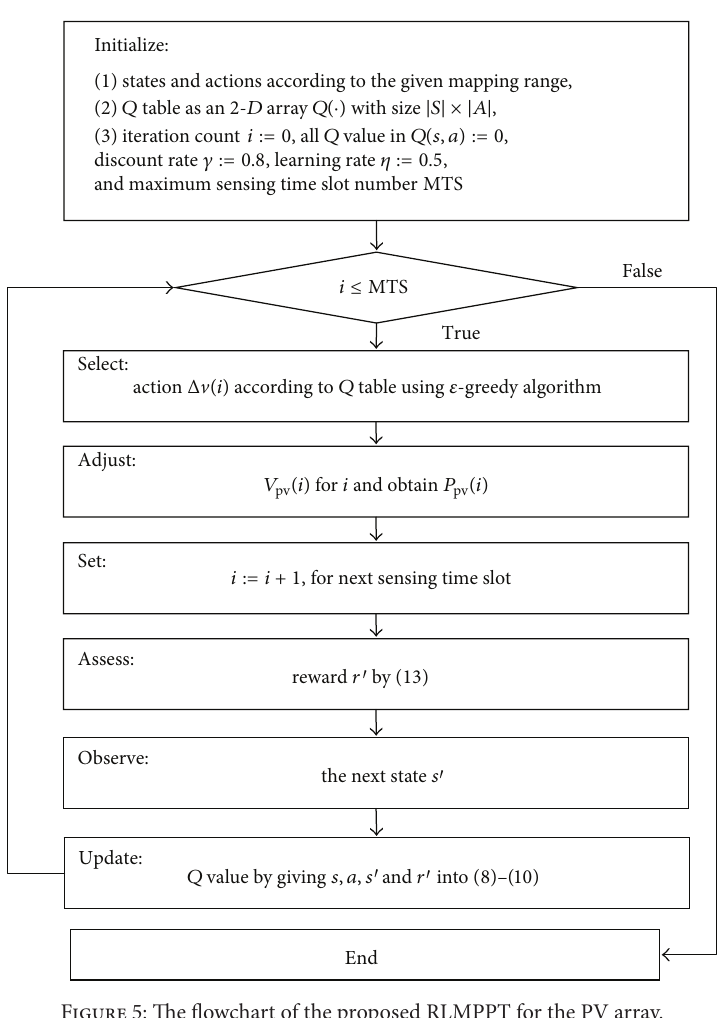
Figure 5: The flowchart of the proposed RLMPPT for the PV